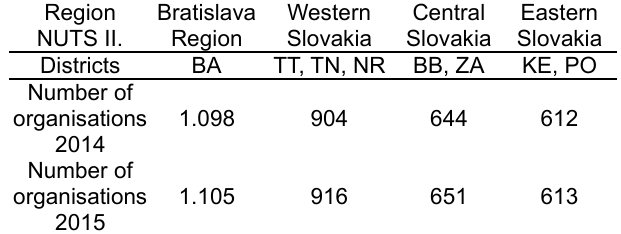
Table 2. Regional structure of organisations with more than 50 employees (source: data processed accord-ing to the Statistical Office of the Slovak